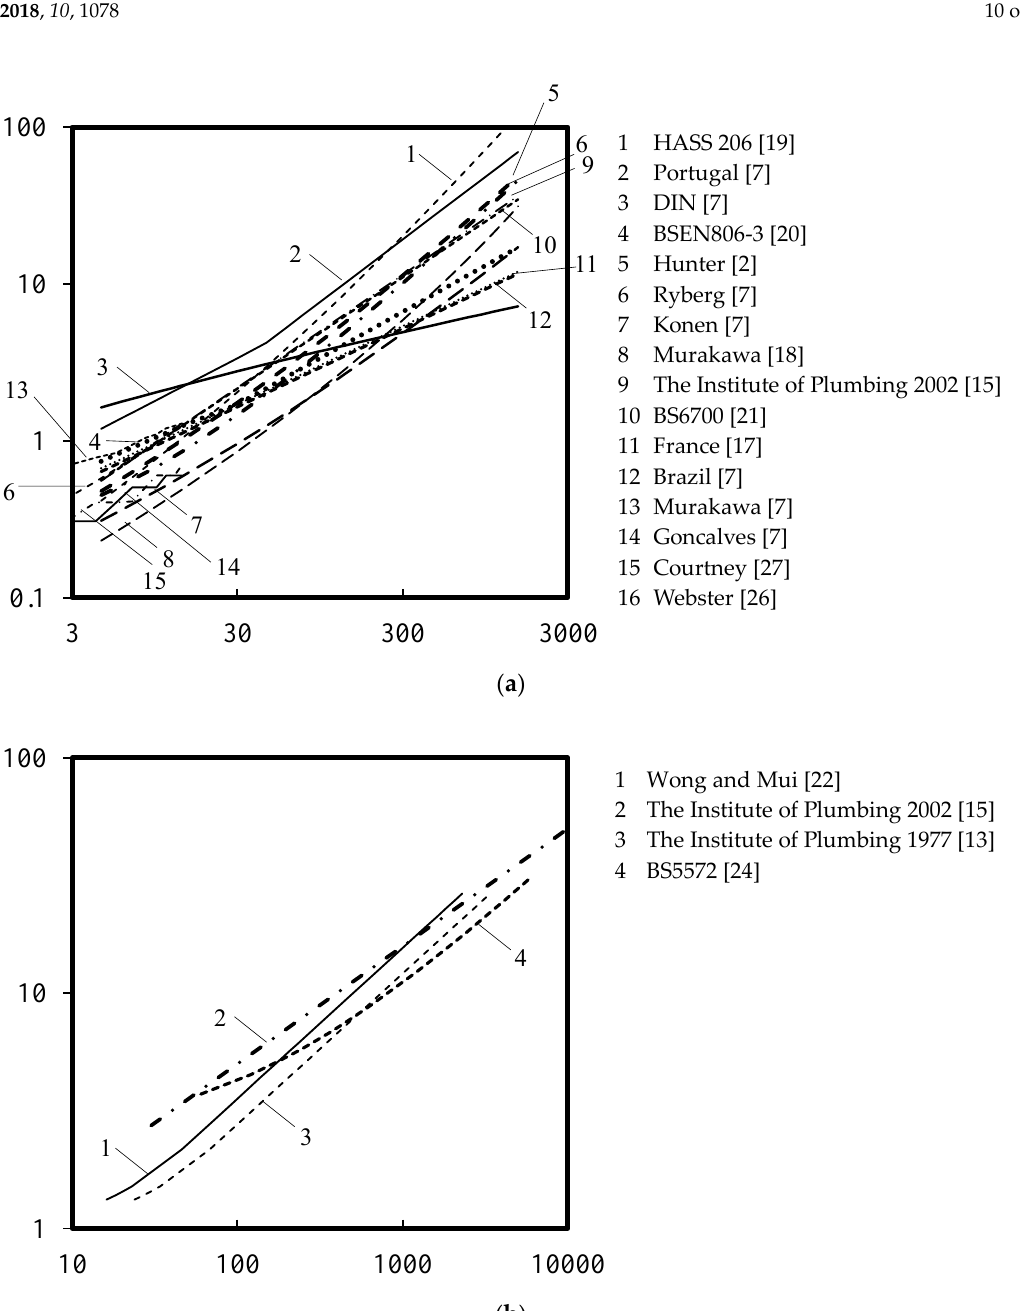
Figure 3. Design flow rates of residential fixture units. ( a ) water supply; ( b ) drainage. x -axis: maximum flow rate M 0 q 0 (L · s − 1 ). y -axis: design flow rate q s (L · s − 1 ).